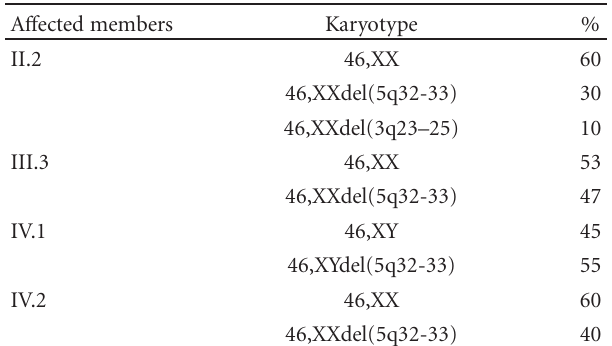
Table 2: Mosaicism of deletions 5q and 3q in the a ff ected members. A ff ected